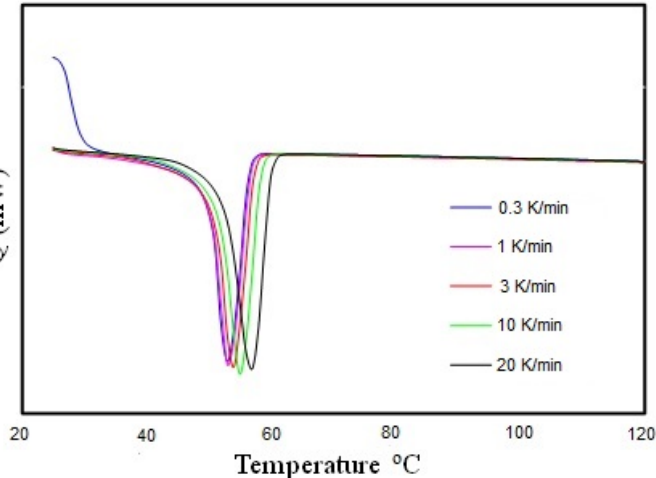
Figure 10. Heat flow curves of PCL nanofibers as a function of cooling rate q as indicated and heating rate 10 K/min.